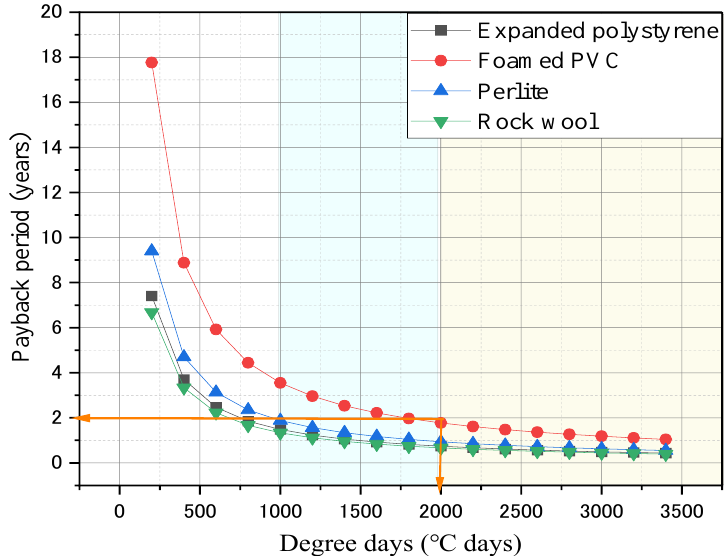
Figure 10. The relationship between degree-days and the payback period for different insulating materials at the optimum thickness.